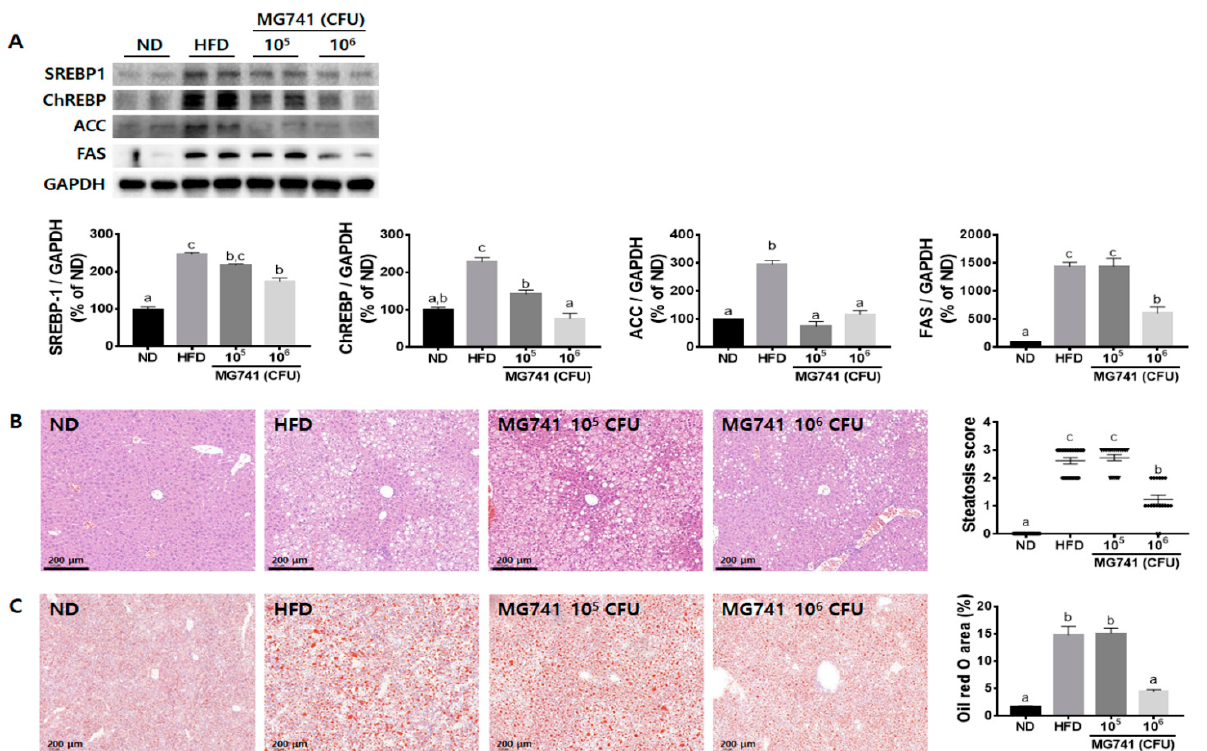
Figure 3. Bifidobacterium animalis ssp. lactis MG741 (MG741) ameliorates high-fat-diet-induced changes in lipid metabolism in the liver. ( A ) Representative Western blots of SREBP-1, ChREBP, ACC, and FAS. ( B ) Representative histological results based on H&E staining and steatosis score. ( C ) Representative histological results based on Oil Red O staining and the positive staining area. Data are presented as the mean ± standard error of the mean ( n = 6). The different letters (a–c) indicate significant differences ( p < 0.05) determined by one-way ANOVA with Tukey’s post hoc tests.